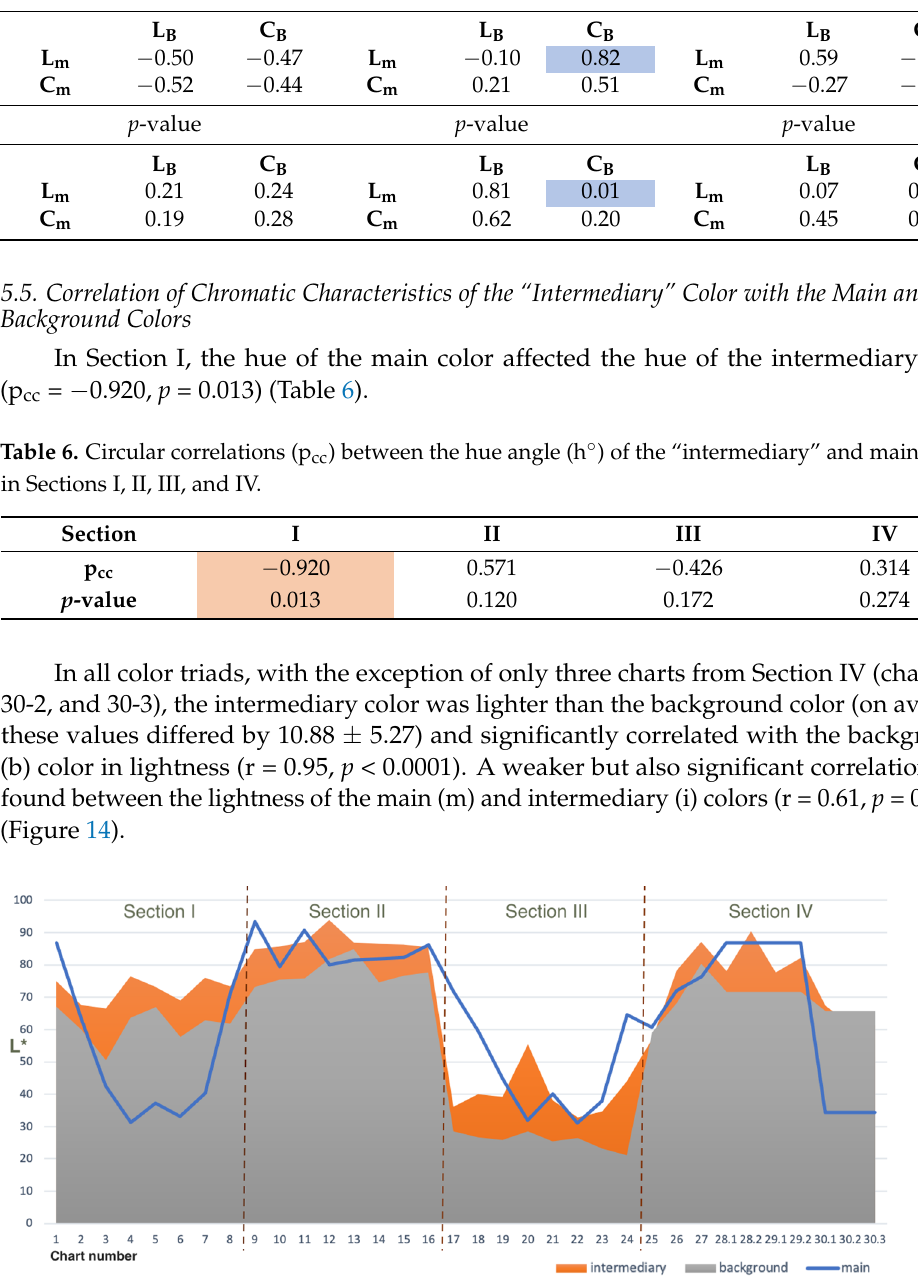
Figure 14. Lightness (L) of the corresponding intermediary, background, and main colors in the charts of Sections I–IV of the Reference Book.